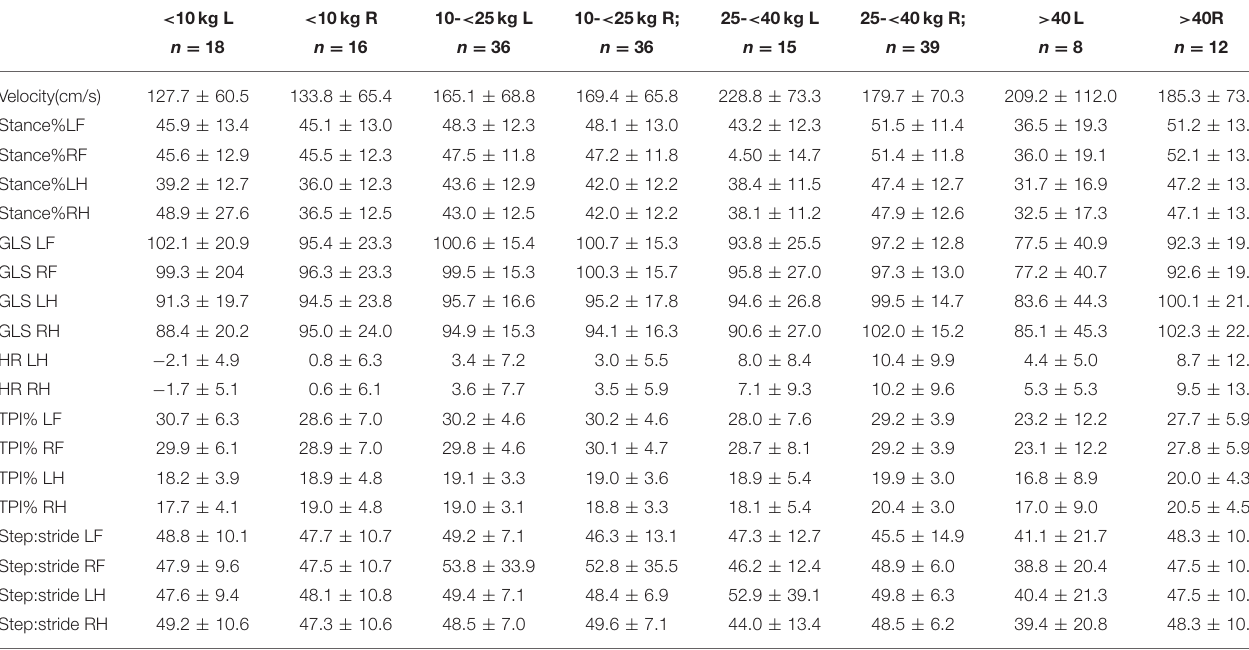
TABLE 2 | Data at the trot expressed as mean ± standard deviation.